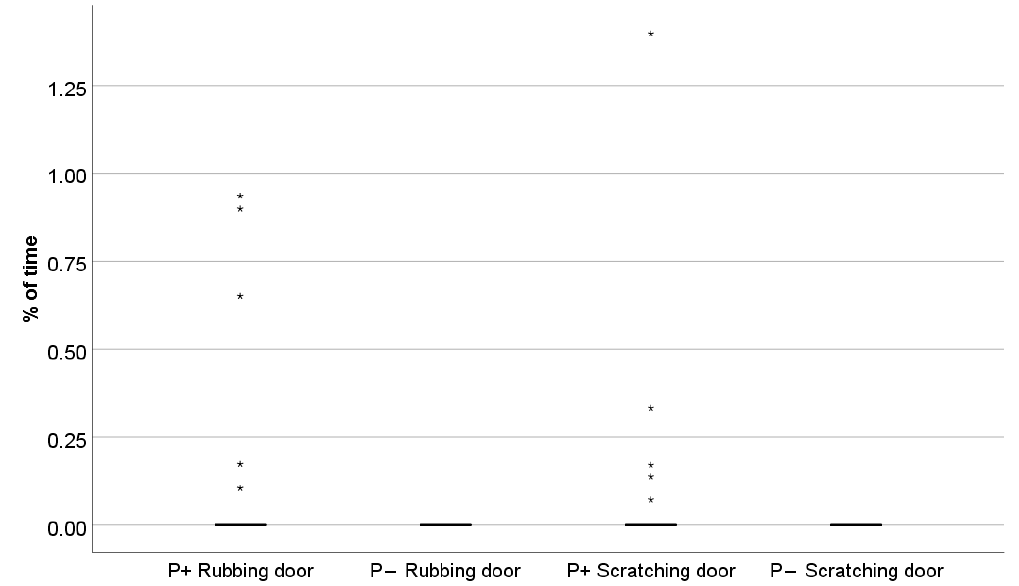
Figure 4. Percentage of time cats scratched and rubbed the door in the two conditions (P+: auditory enrichment with a human present; P − : auditory stimulation without human presence). The cats showed door scratching (Wilcoxon test: p = 0.043) and rubbing (Wilcoxon test: p = 0.043) only in the presence of the human (Wilcoxon test: p = 0.043). * depicts outlier.